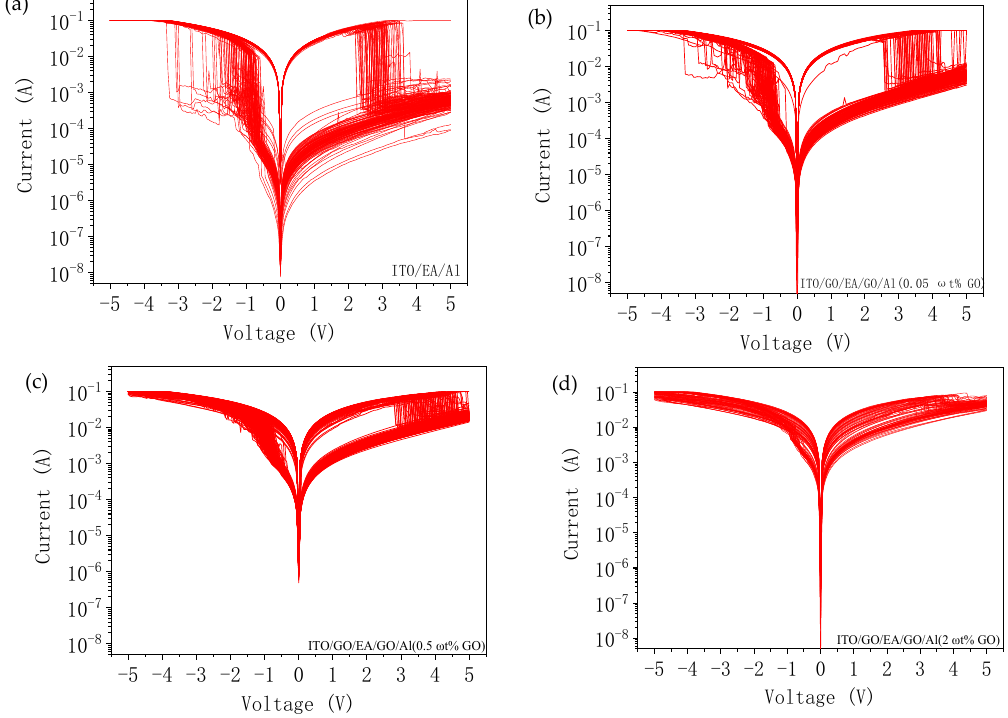
Figure 9. I-V characteristics under continuous cyclic scanning: ( a ) ITO/EA/Al device. ( b – d ) ITO/GO/EA/GO/Al devices with GO concentrations of ( b ) 0.05 ωt%, ( c ) 0.5 ωt%, and ( d ) 2 ωt%.